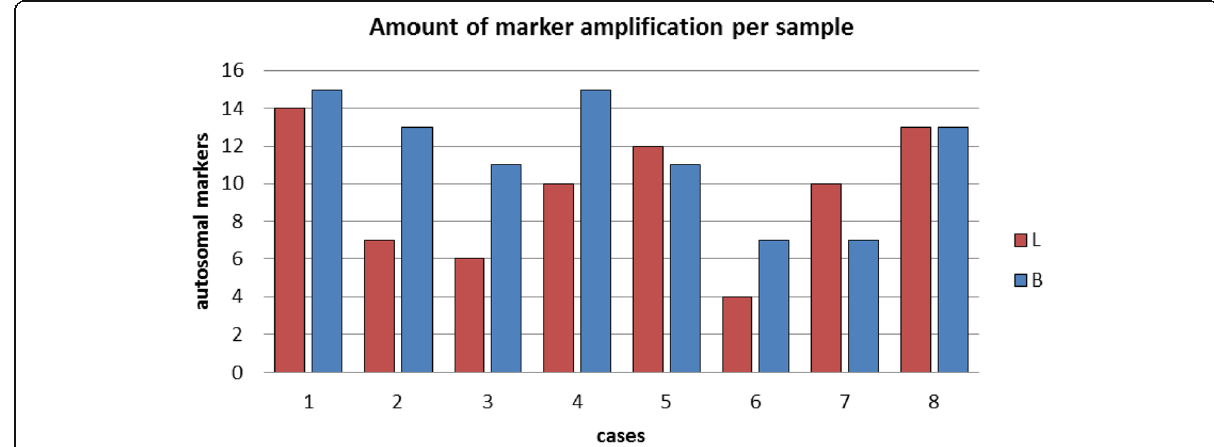
Fig. 3 Amount of amplified markers in accordance with contamination criteria